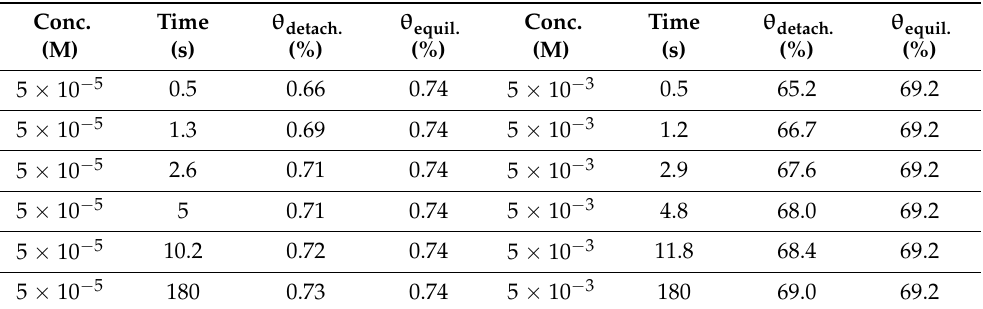
Table 1. Detaching and equilibrium adsorption coverages for n-hexanol solutions of 5 × 10 − 5 M and 5 × 10 − 3 M for various adsorption